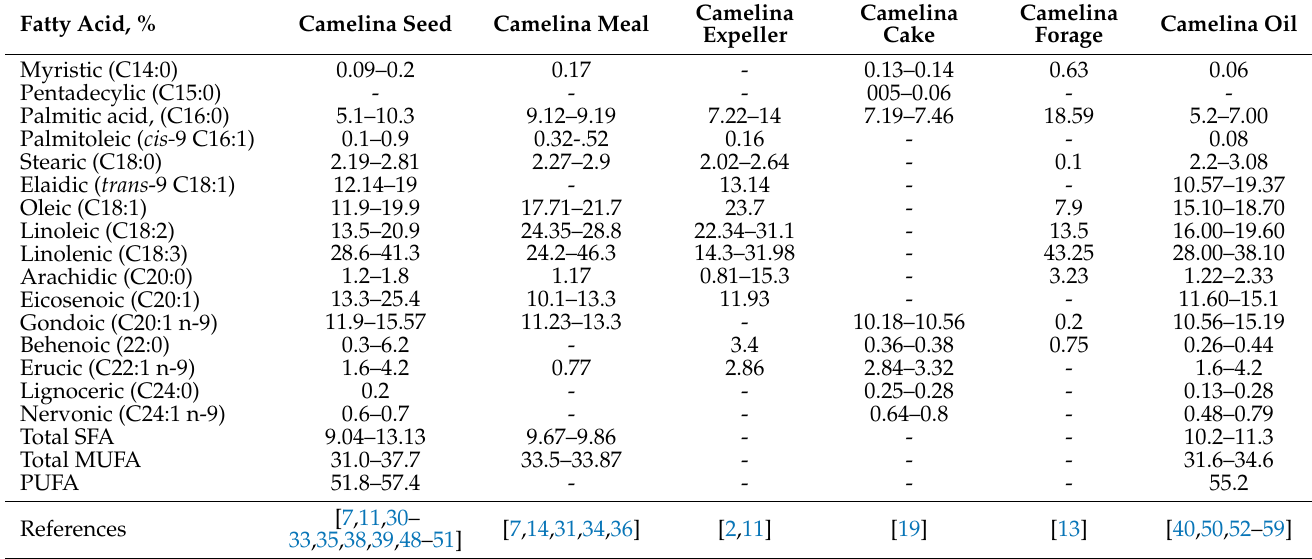
Table 3. Fatty acid profile of Camelina sativa seed, meal, expeller, cake, and forage (% total fatty